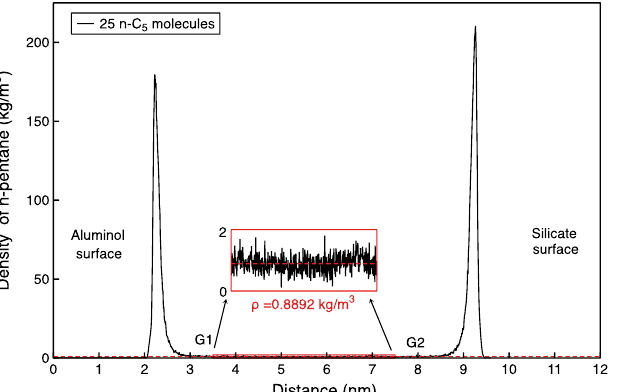
Figure 4. Density distribution curve of 25 n-pentane molecules with free phase hydrocarbon density of 0.8892 kg/m 3 .